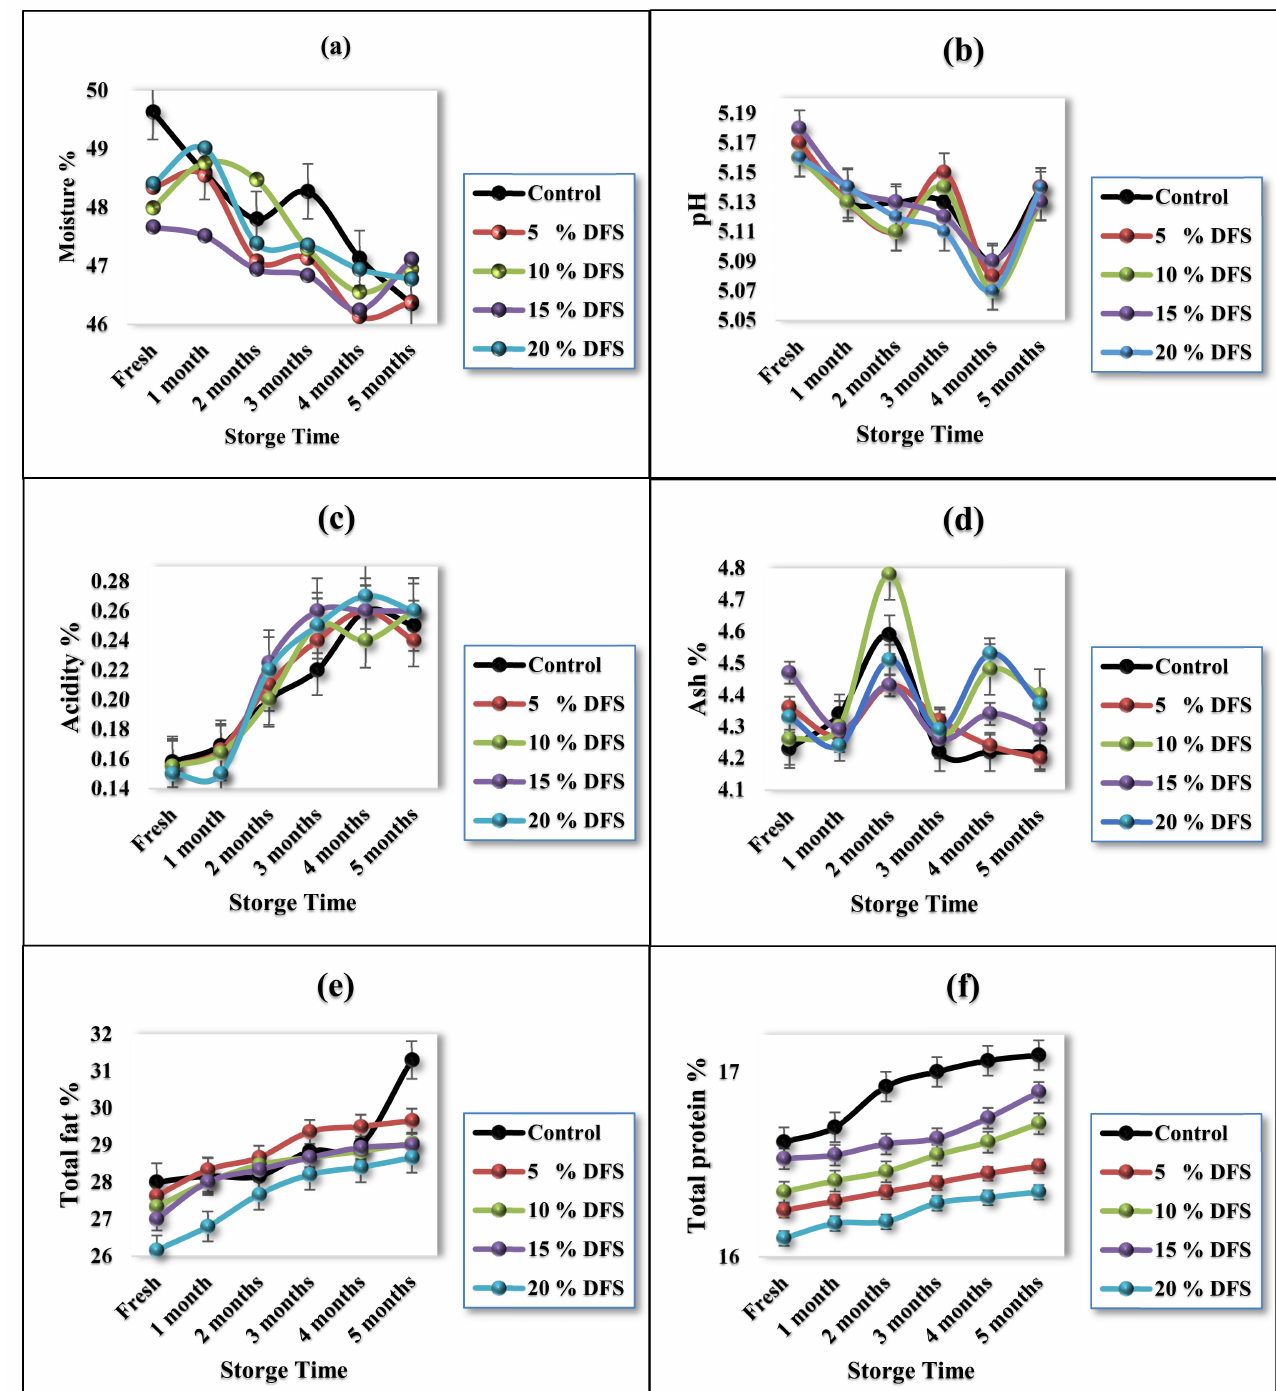
Figure 3. ( a – f ) Characterization of cheeses fortified with 5%, 10%, 15%, and 20% DFS as a partial substitution for butter in moisture, pH, acidity, ash, total fat, and total protein % during